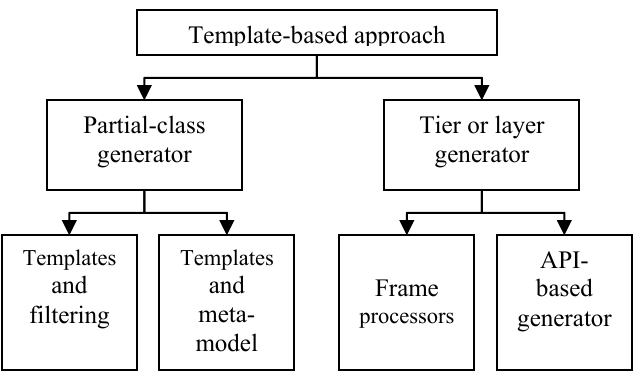
Fig. 2. Template-based approach taxonomy